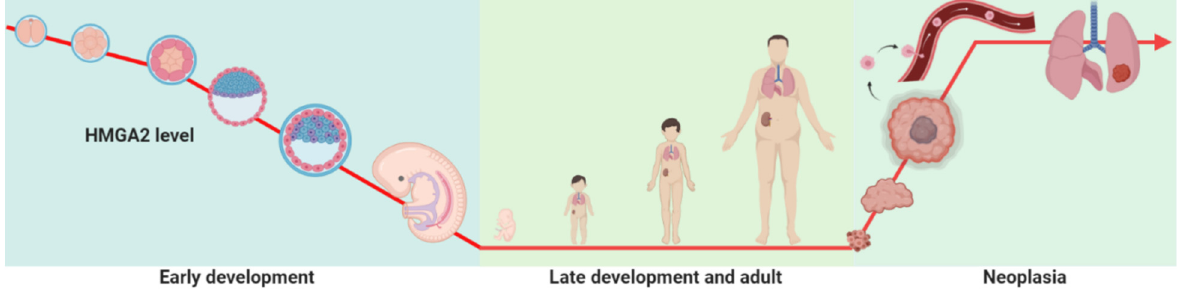
Figure 2. HMGA2 expression level during development and neoplasia. HMGA2 is highly expressed during early embryonic development. In contrast, in late development and during adulthood, the expression levels of this are low. However, the expression of HMGA2 is increased during the development of cancer.